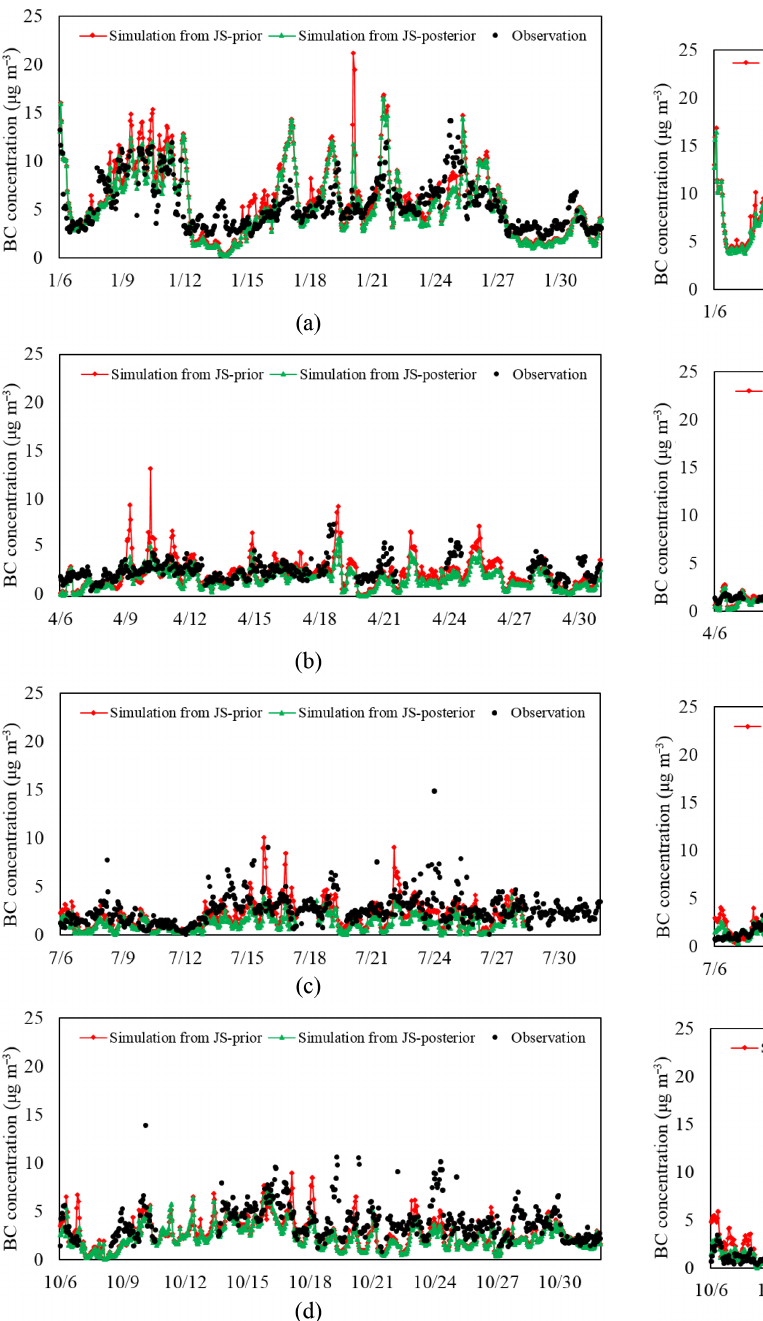
Figure 3. The observed and simulated hourly BC concentrations at NJU using JS-prior and JS-posterior for January (a) , April (b) , July (c) , and October (d) in 2015 (unit: µgm − 3 ).